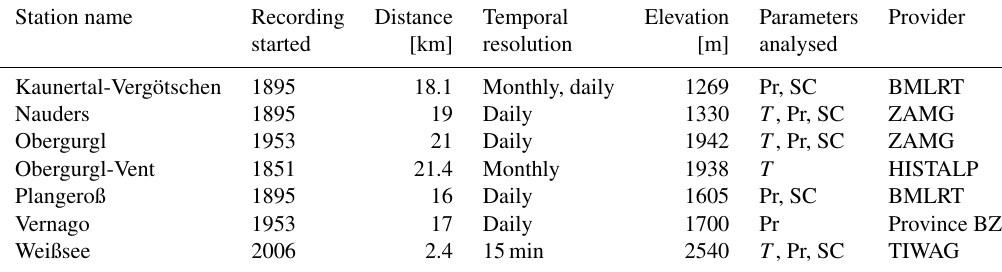
Table 3. Overview of the meteorological stations used. The distance is given to the centre of the study area in kilometres. T – temperature, Pr – precipitation, SC – snow cover. The data were provided by the “Federal Ministry of Agriculture, Regions and Tourism” (BMLRT), the “Central Institute for Meteorology and Geodynamics” (ZAMG), “Historical Instrumental Climatological Surface Time Series of the Greater Alpine Region” (HISTALP), “Autonomous Province of Bozen/Bolzano” (Province BZ), and